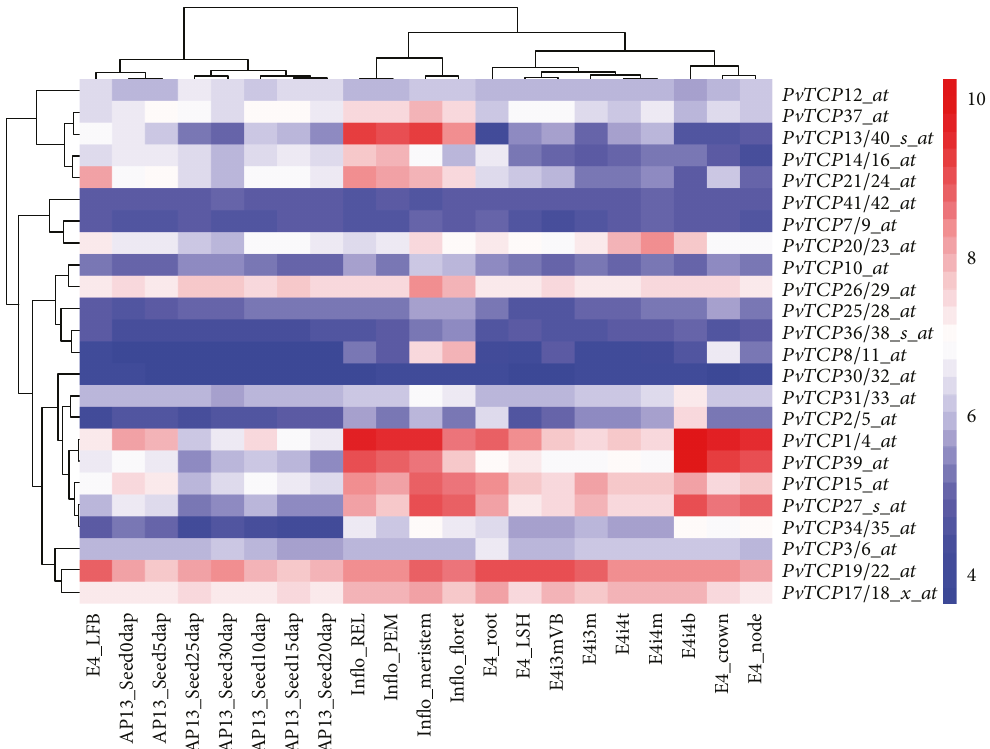
Figure 6: Heatmap of expression pro fi les of switchgrass TCP gene pairs in di ff erent tested tissues. The detailed microarray data were obtained from switchgrass gene atlas database (https://switchgrassgenomics.noble.org/). Clustering analysis was carried out using the online program pretty heatmap (http://www.ehbio.com/ImageGP/index.php/). The detailed information was listed in Table